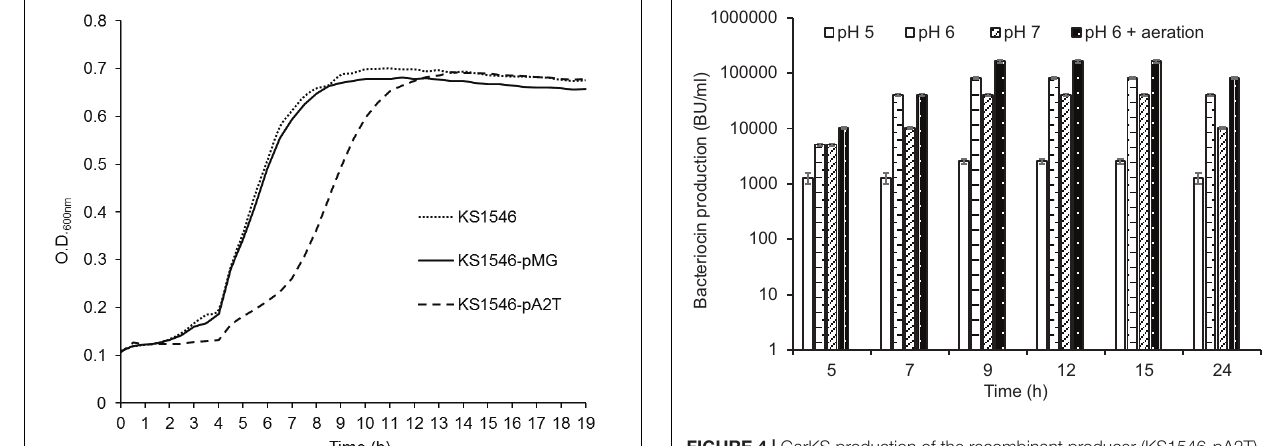
particles causing problem for spectrophotometric reading). The